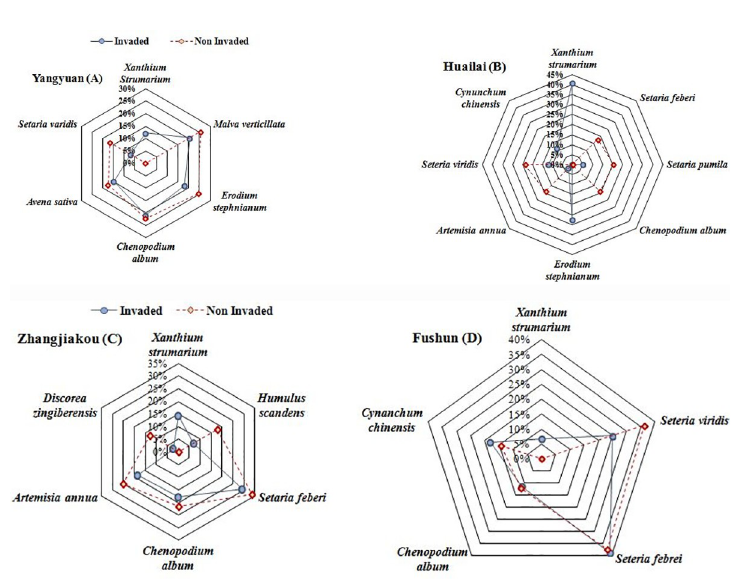
Fig 4. Web plot showed the interspecific competition between different plant species in invaded and non-invaded quadrats based on relative abundance. The central point is 0%, each ring gives the indication of the magnitude (%) of interspecific competition among plants in invaded and non-invaded